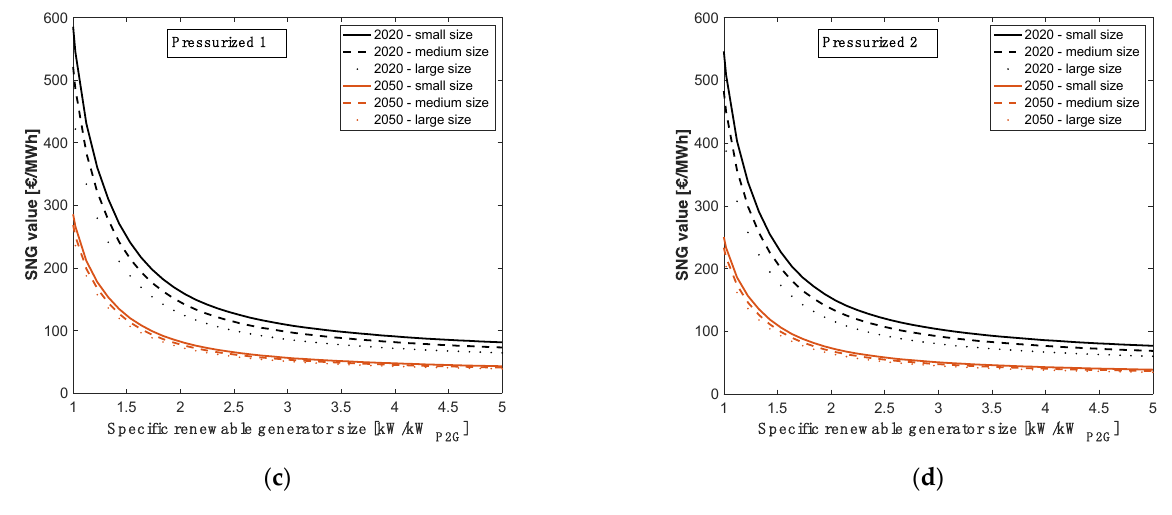
Figure 14. SNG value as a function of the SOEC cost development and of the renewable generator size for the several P2G thermodynamic configurations: ( a ) Ambient 1; ( b ) Ambient 2; ( c ) Pressurized 1; and ( d ) Pressurized 2.